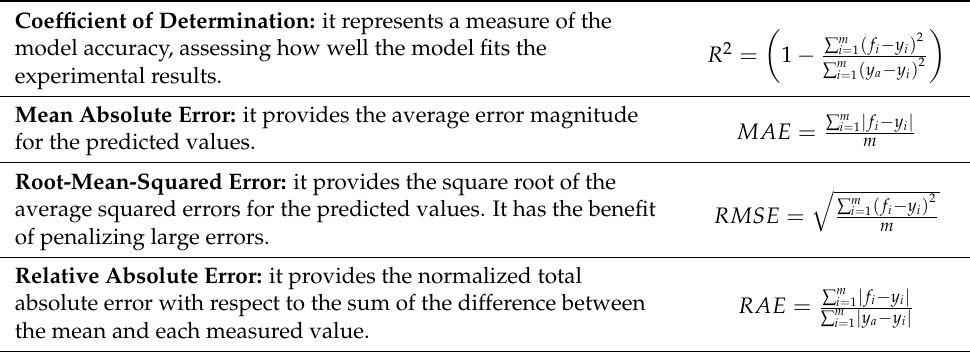
Table 1. Evaluation